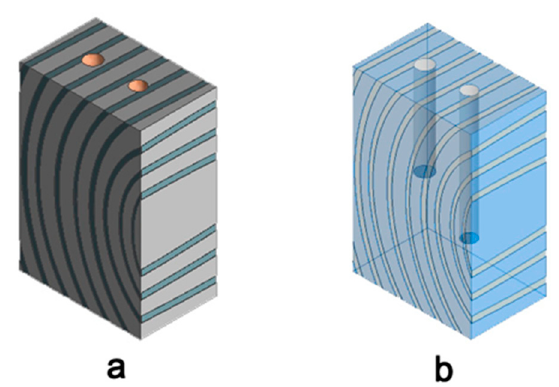
Figure 3. Specimen ( a ) Location of the different tests; ( b ) Projection of the holes inside the specimen, the difference in the depth of the drills made can be seen in the image.